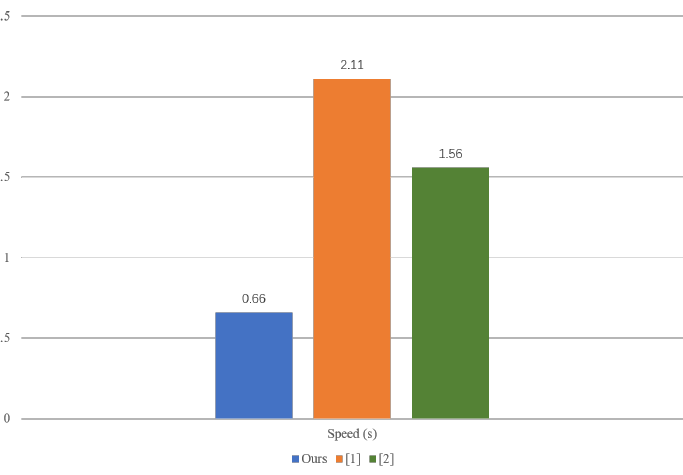
Figure 21. Comparison speed results between our method and [20,21].